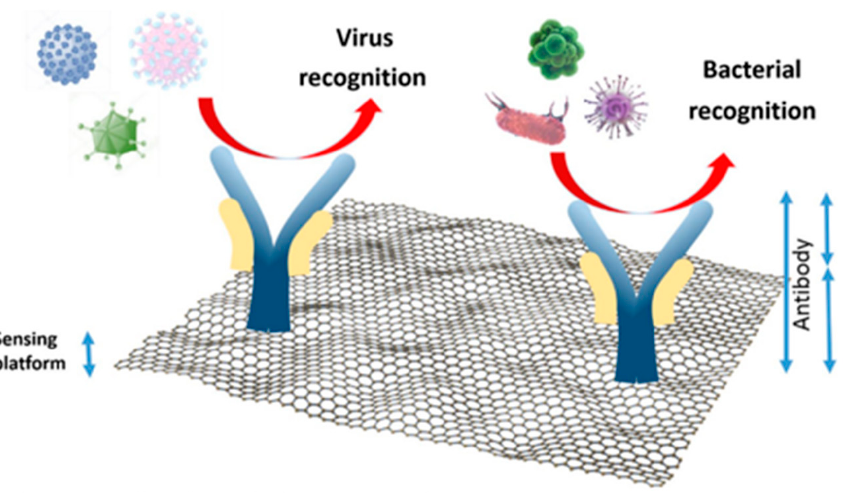
Figure 8. Schematic illustration of graphene-based biosensor. Reprinted with permission from Ref. [65].